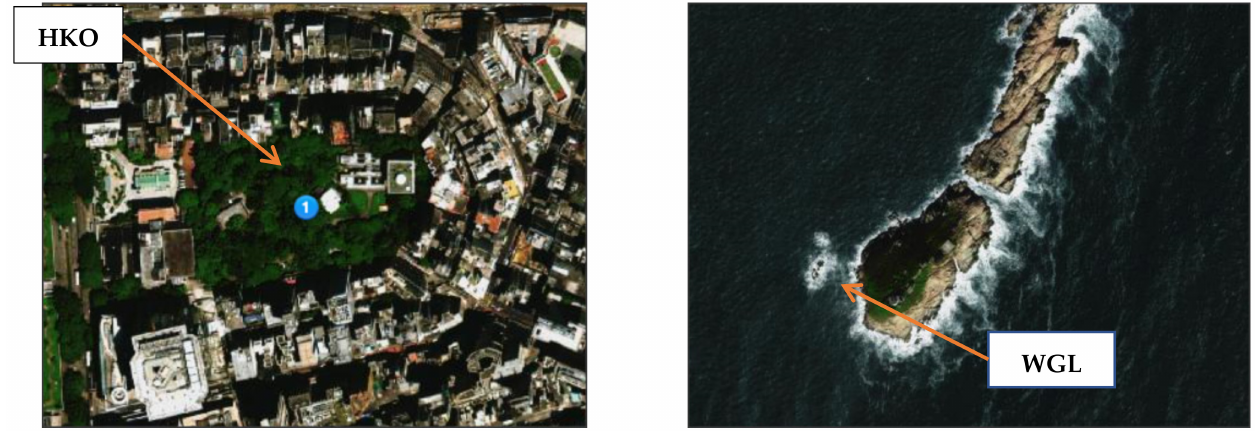
Figure 3. The enlarged surrounding environment for the HKO and the WGL station. In order to make a direct comparison between the simulated and observed wind speeds and directions, the simulated typhoon wind fields that were extracted from the innermost domain (D04) were interpolated to the corresponding locations and heights using the cubic spline method [37]. Given that the wind field should vary smoothly in reality, the cubic spline interpolation produces an accurate and smooth estimate of both wind speeds and directions at the observation location. For the sake of brevity, only two comparisons, which were chosen randomly from all of the comparisons in each typhoon case, are illustrated in Figures 4 and 5 in order to show the general accuracy of the simulation results.